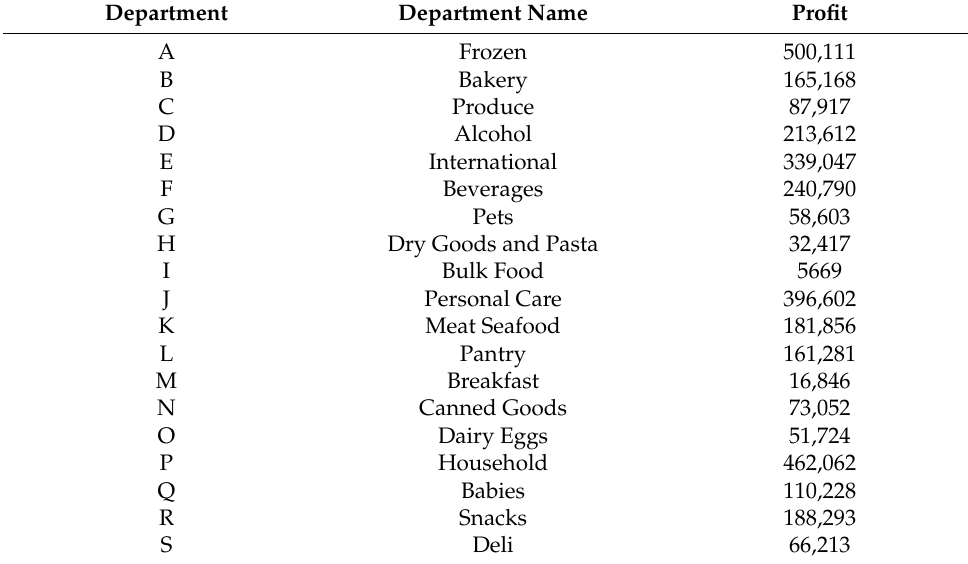
Table 4. Profits of departments.